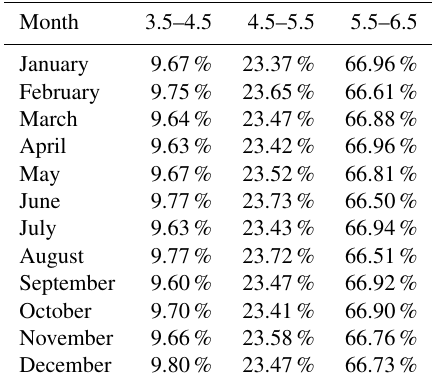
Table 8. Star magnitude statistics of AGRI.